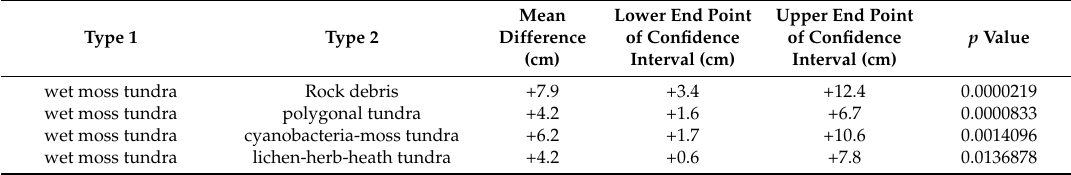
Table 5. Statistically significant ( p value < 0.05) mutual relations between snow depth on different land cover types. The analysis was performed for the whole period 2014–2016 with date as covariate (after excluding outlier values at the foothill of Fugleberget